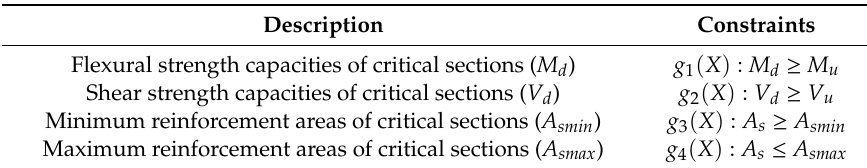
Table 2. Design constraints on strength and